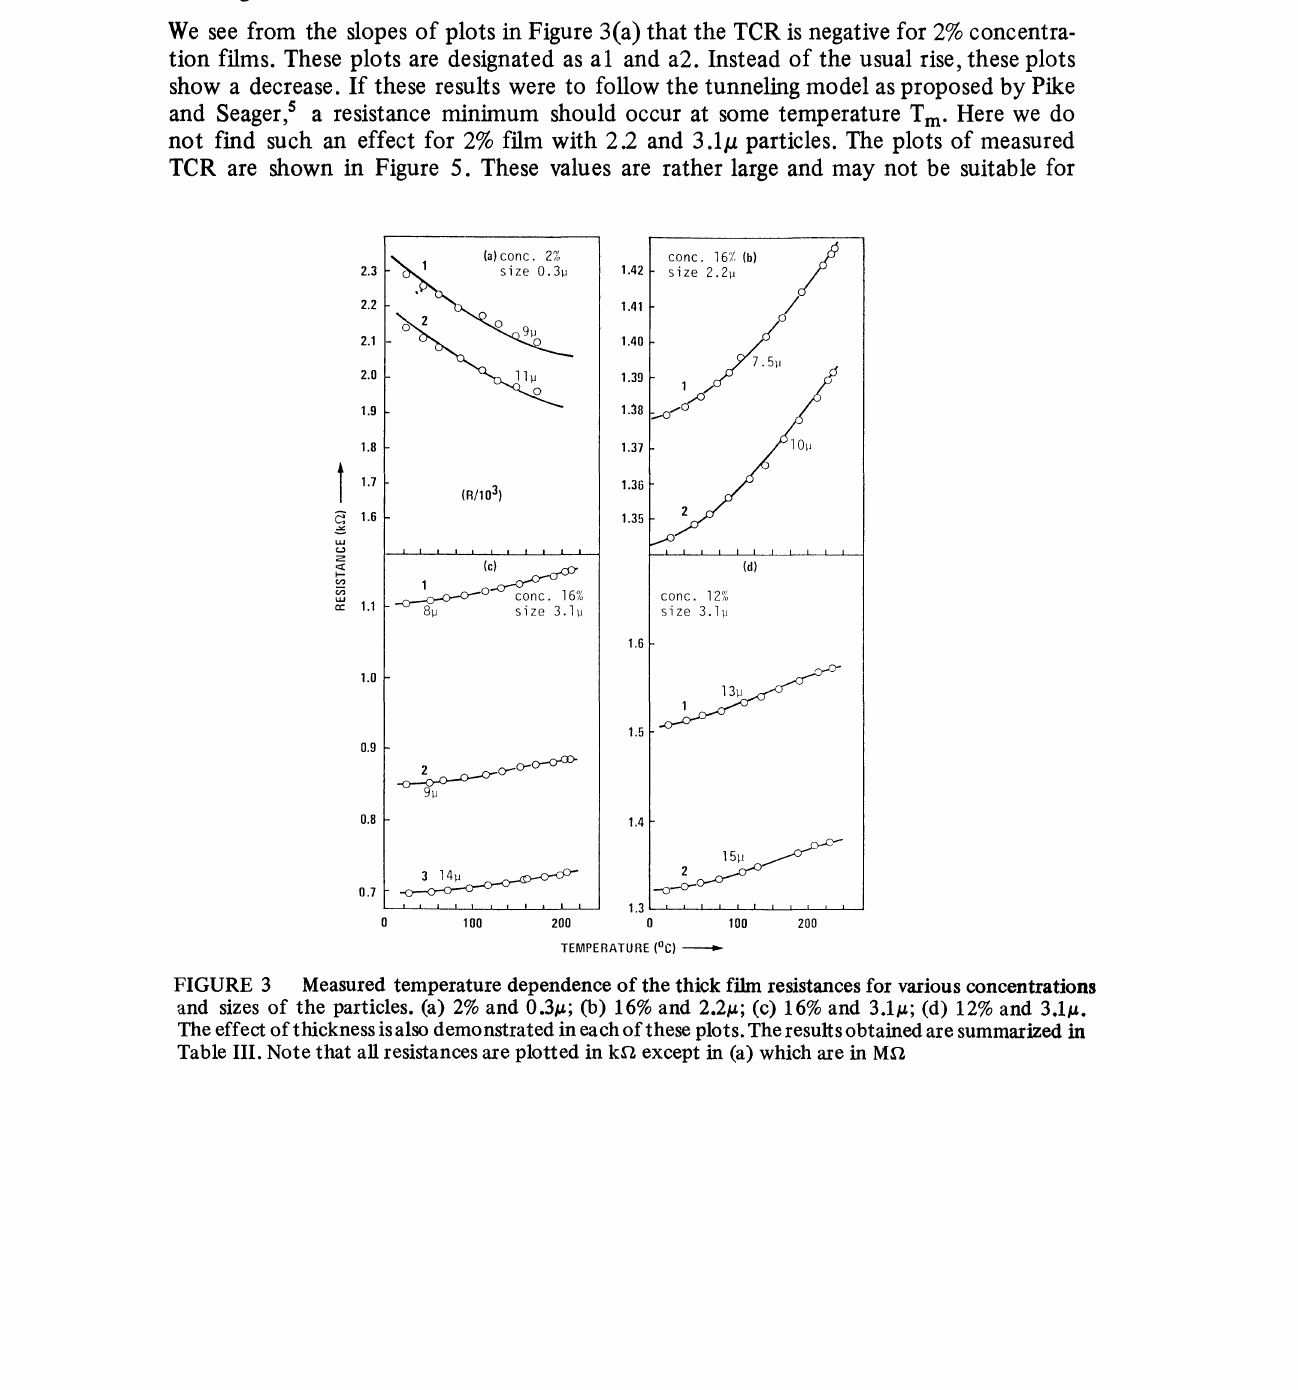
Measured temperature dependence of the thick film resistances for various concentrations and sizes of the particles. (a) 2% and 0.3; (b) 16% and 2.2t; (c) 16% and 3.1; (d) 12% and